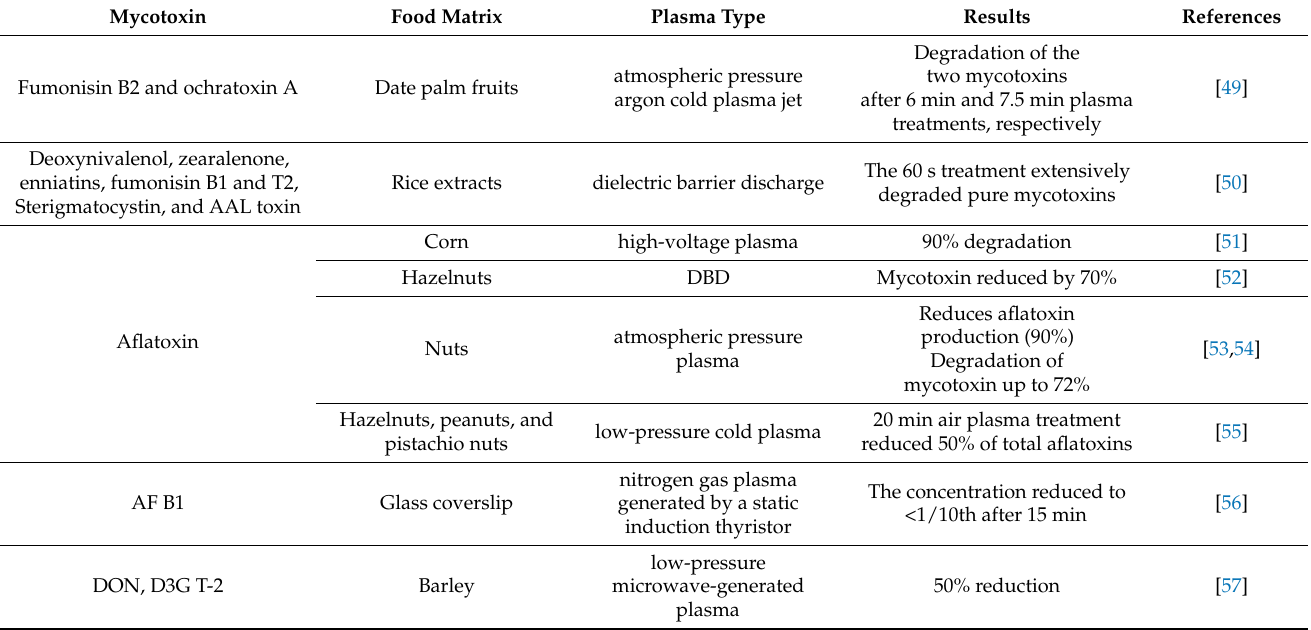
Table 1. Cold plasma experiments illustrating mycotoxin degradation.